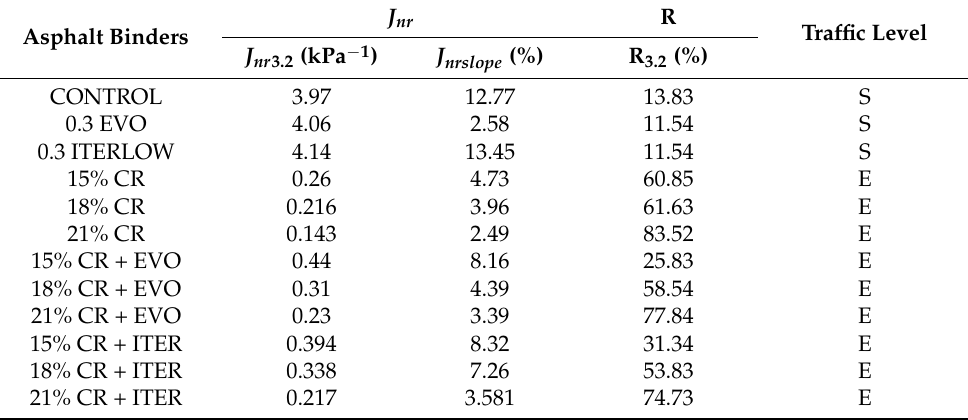
Table 5. Results of MSCR test.